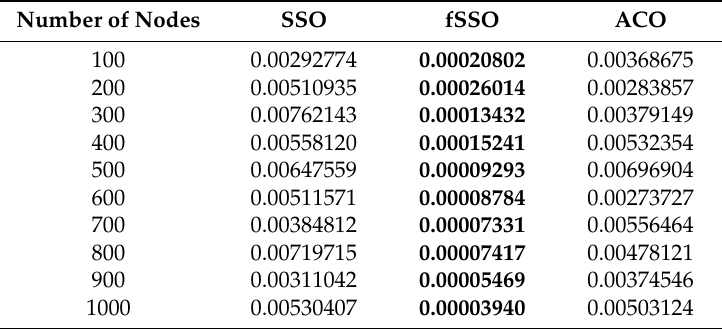
Table 15. Standard deviation of fitness values of fSSO compared with SSO and ACO for ten benchmarks. Number of Nodes SSO fSSO ACO